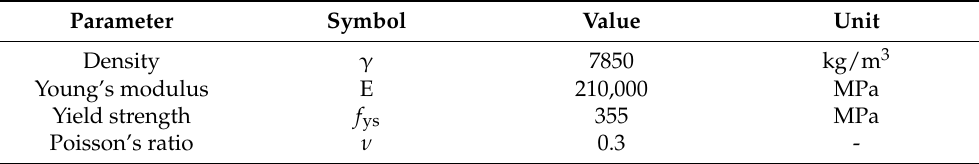
Table 3. Material properties used for 4-leg jacket substructure. Parameter Symbol Value Unit Density γ 7850 kg/m 3 Young’s modulus E